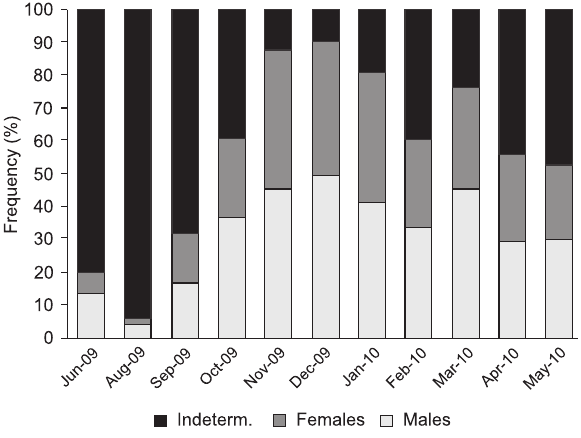
Figure 2. Distribution frequency of indeterminate sex, females, and males of Scolelepis goodbodyi during the sampling